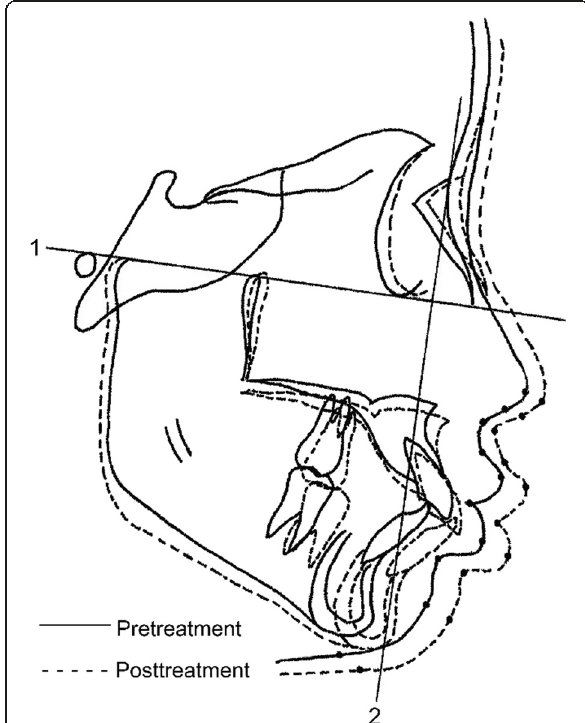
Fig. 2 Reference points and reference planes utilized for evaluation